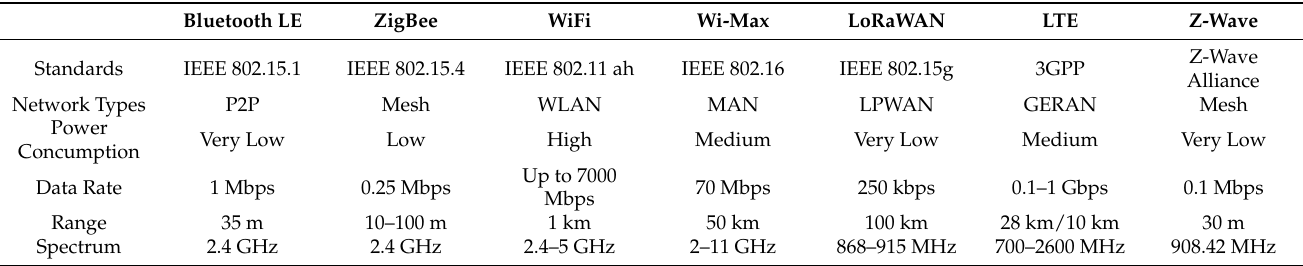
Table 1. Wireless technology comparison of key features. Adapted from: Security and Privacy Issues in IOT Things